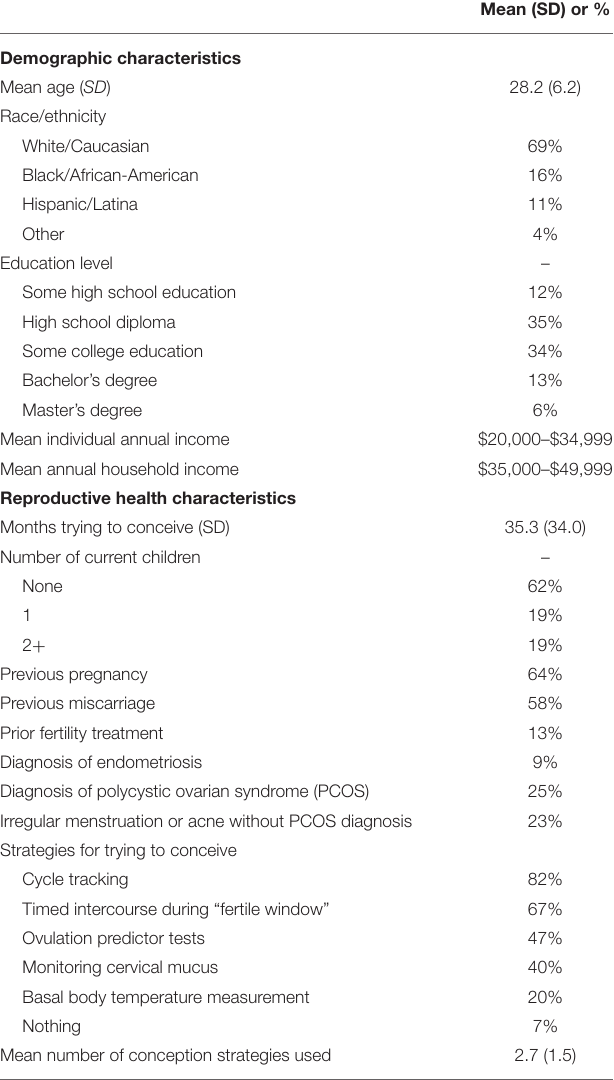
TABLE 1 | Participant